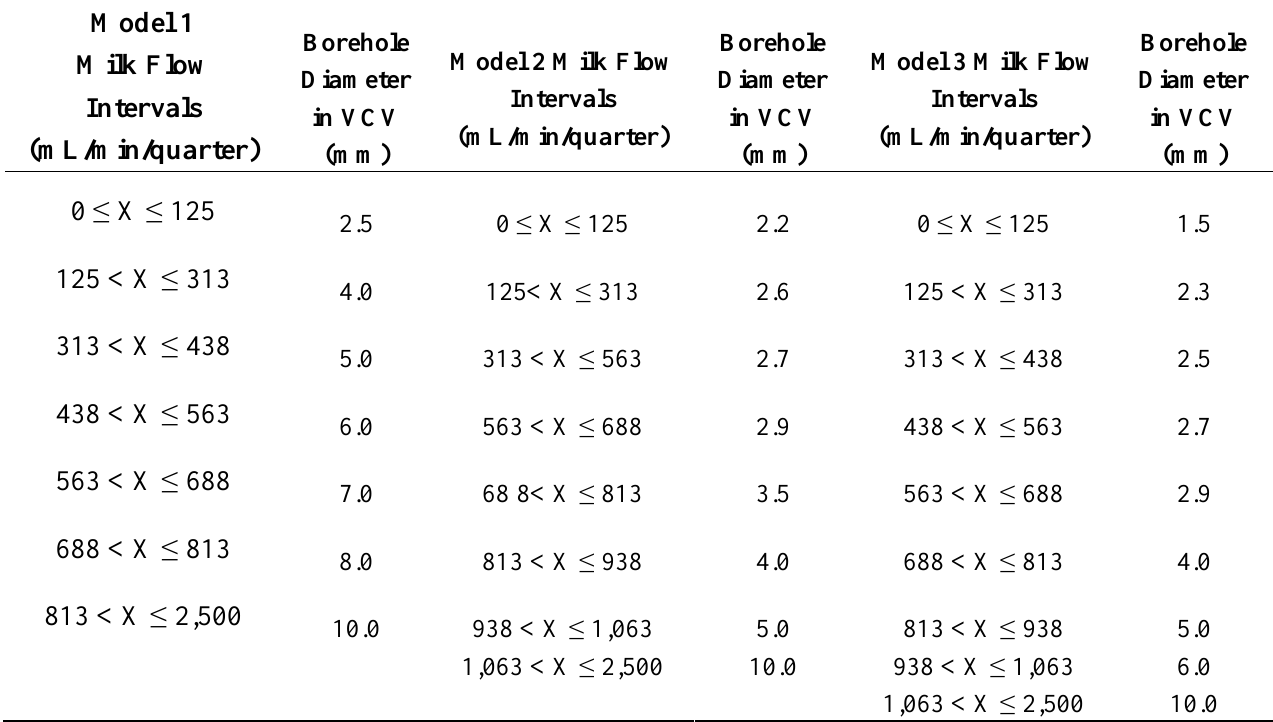
Table 1. Three developed control models 1–3 for controlling the teat-end vacuum with different desired effects on the vacuum